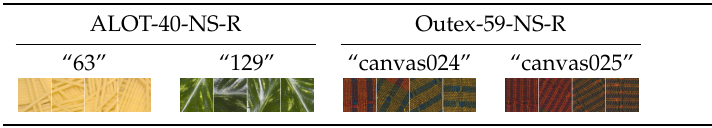
Figure 6. Group #6: Non-stationary textures with rotation (Section